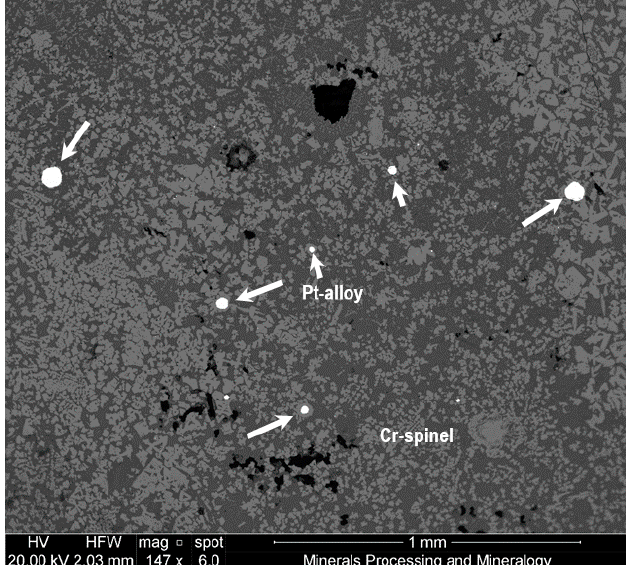
Figure 22. SEM image of the slag from the UG-2 product (low sulphur feed). Note the presence of large amounts of Cr-rich spinel and the fine droplets on PGE. The large amounts of spinel would have reduced the viscosity of the slag-inhibiting settling of the PGE-alloys.